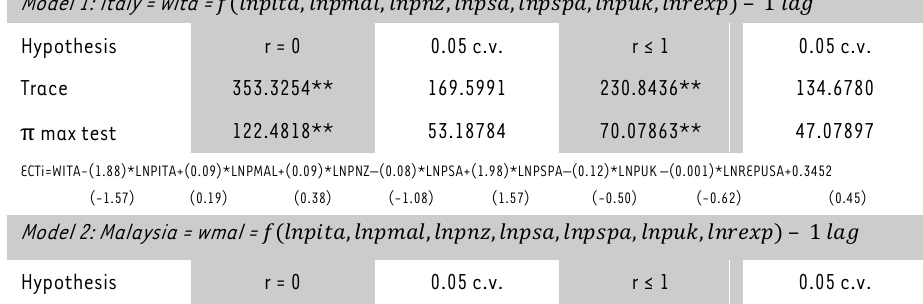
TABLE 4: Johansen co-integration test results for the USA Model 1: Italy = wita